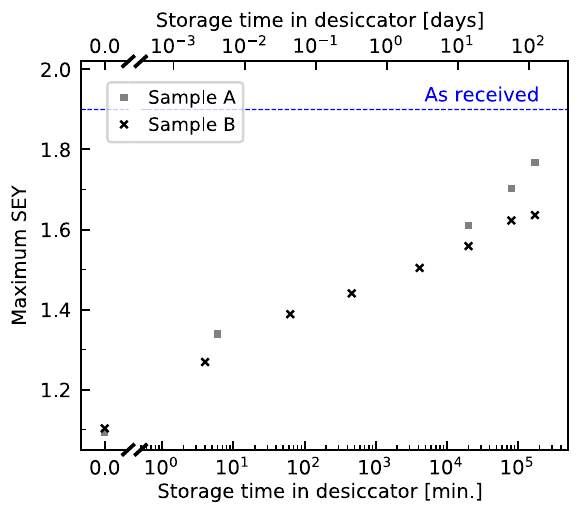
FIG. 2. SEY curves of an OFE copper sample stored in a desiccator after full conditioning. The dotted lines indicate the energy position of the maximum